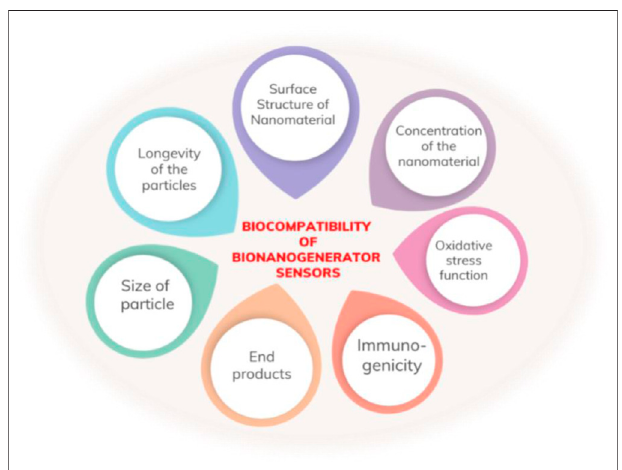
FIGURE 6 | Biocompatibility of bio-nanogenerator